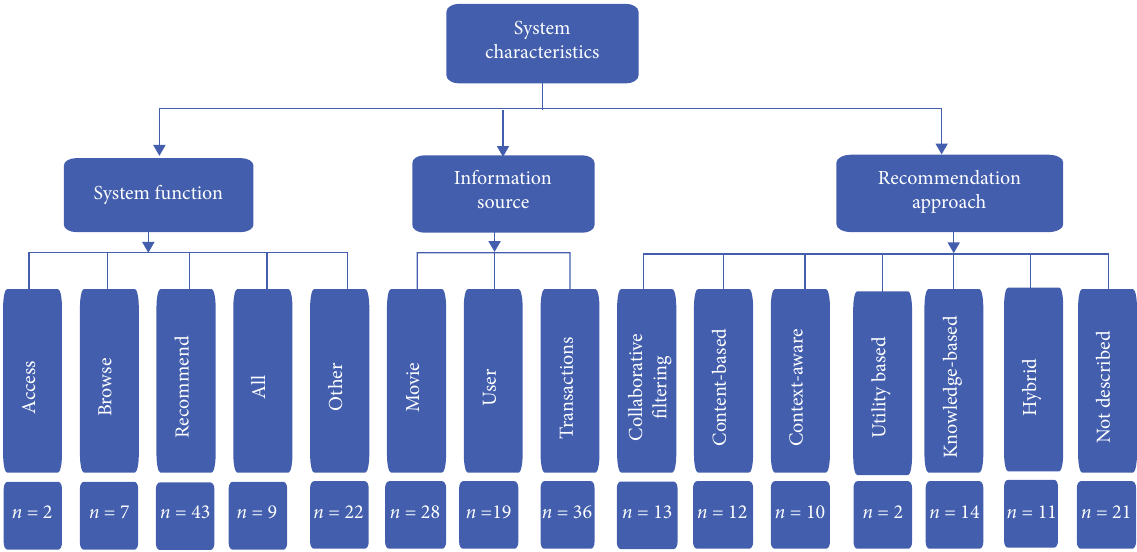
Figure 4: System function, information source, and recommendation